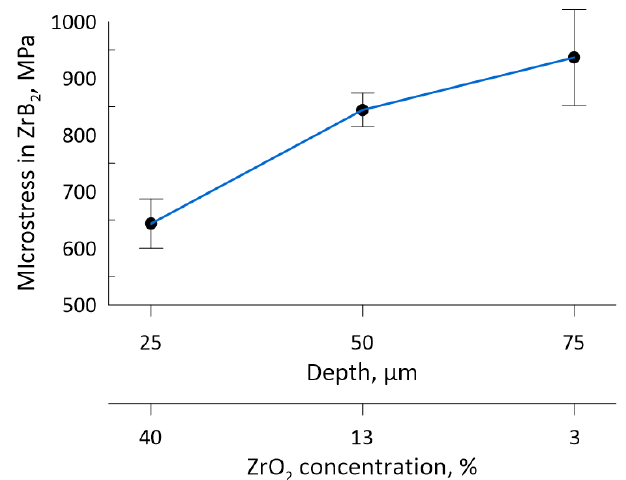
Figure 7. Variation of microstresses in ZrB 2 with distance from the surface of the studied ceramic sample.